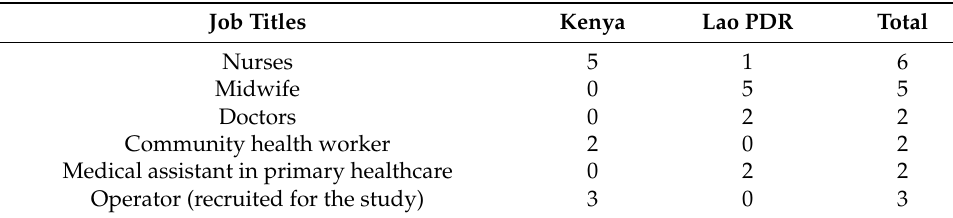
Table 1. Job titles of healthcare workers interviewed after working in the WIRE system.